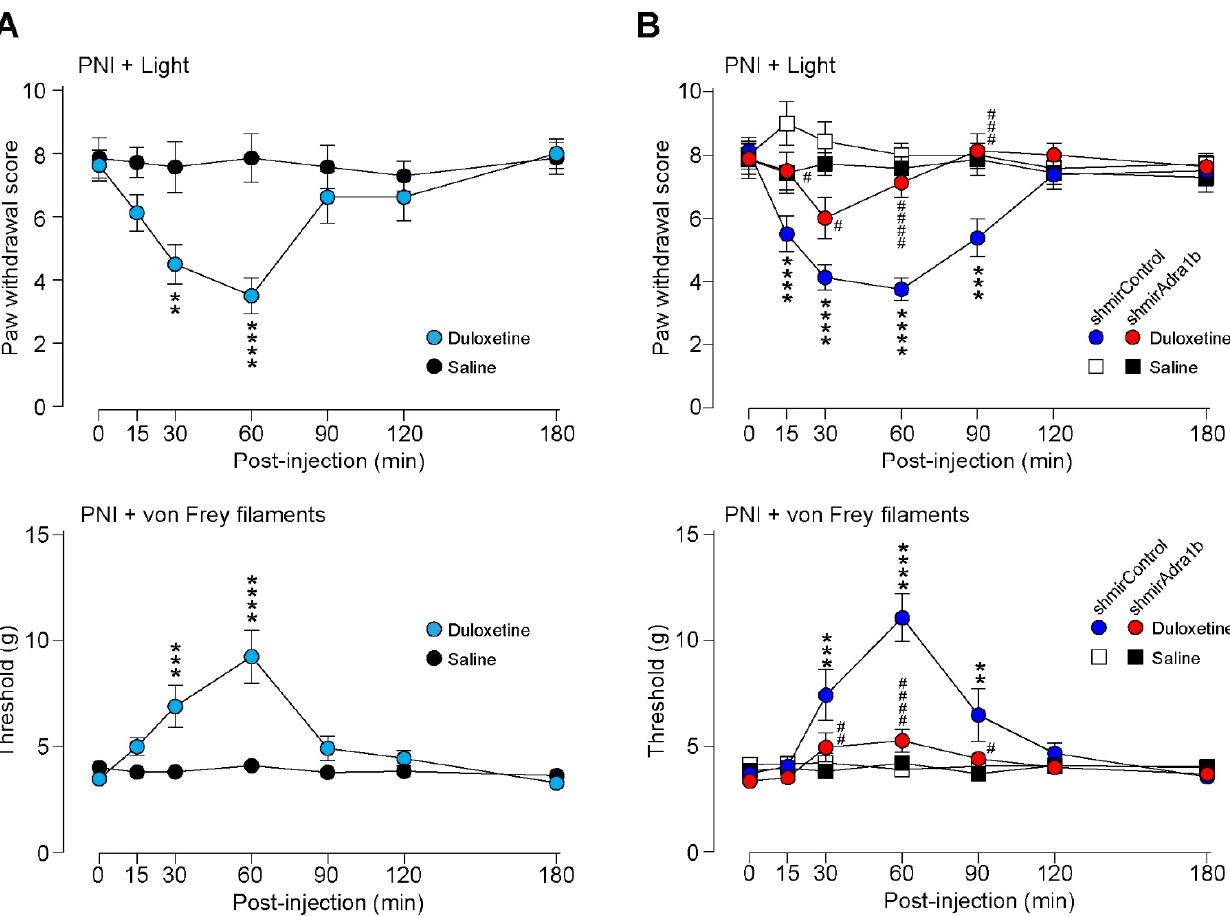
Figure 3. Duloxetine alleviates neuropathic allodynia − like behavior in W − TChR2V4 rats via α 1B − AR in AAV − NpyP + neurons. ( A ) Paw withdrawal responses to light (paw withdrawal score; see Materials and Methods) and von Frey filaments (threshold) before and after intraperitoneal administration of duloxetine (30 mg/kg) or saline in W − TChR2V4 rats (day 14 post − PNI) ( n = 7 to 8 rats). ** p < 0.01, *** p < 0.001, and **** p < 0.0001 vs. saline − treated group, two − way repeated measures ANOVA with post hoc Bonferroni’s multiple comparison test. Data shown as mean ± SEM. ( B ) Effect of α 1B − AR − shRNA expressed in AAV − NpyP + neurons on the alleviating effect of du- loxetine in neuropathic allodynia − like behavior in W − TChR2V4 rats. Paw withdrawal responses to light (paw withdrawal score) and von Frey filaments (threshold) before and after duloxetine or saline administration in AAV − NpyP − shmirControl − or AAV − NpyP − shmirAdra1b − microinjected W − TChR2V4 rats (on day 14 post − PNI) ( n = 7 to 8 rats). ** p < 0.01, *** p < 0.001, and **** p < 0.0001, vs. saline − treated AAV − NpyP − shmirControl − microinjected rats, and # p < 0.05, ## p < 0.01, ### p < 0.001, and #### p < 0.0001, vs. duloxetine − treated AAV − NpyP − shmirControl − microinjected rats, two − way repeated measures ANOVA with post hoc Tukey’s multiple comparison test. Data shown as mean ±